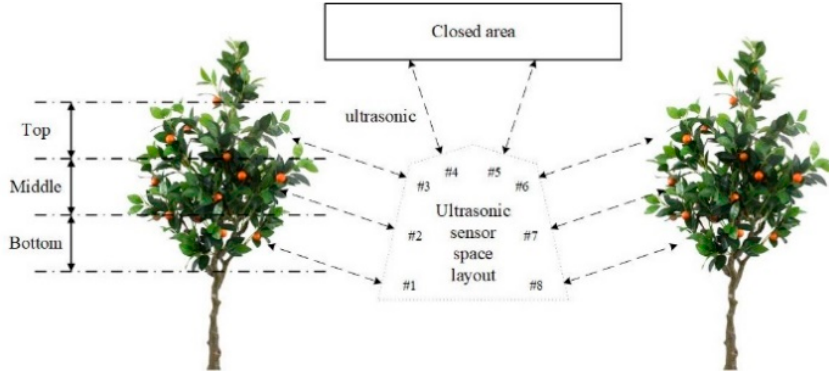
Figure 8. Ultrasonic sensor space layout.